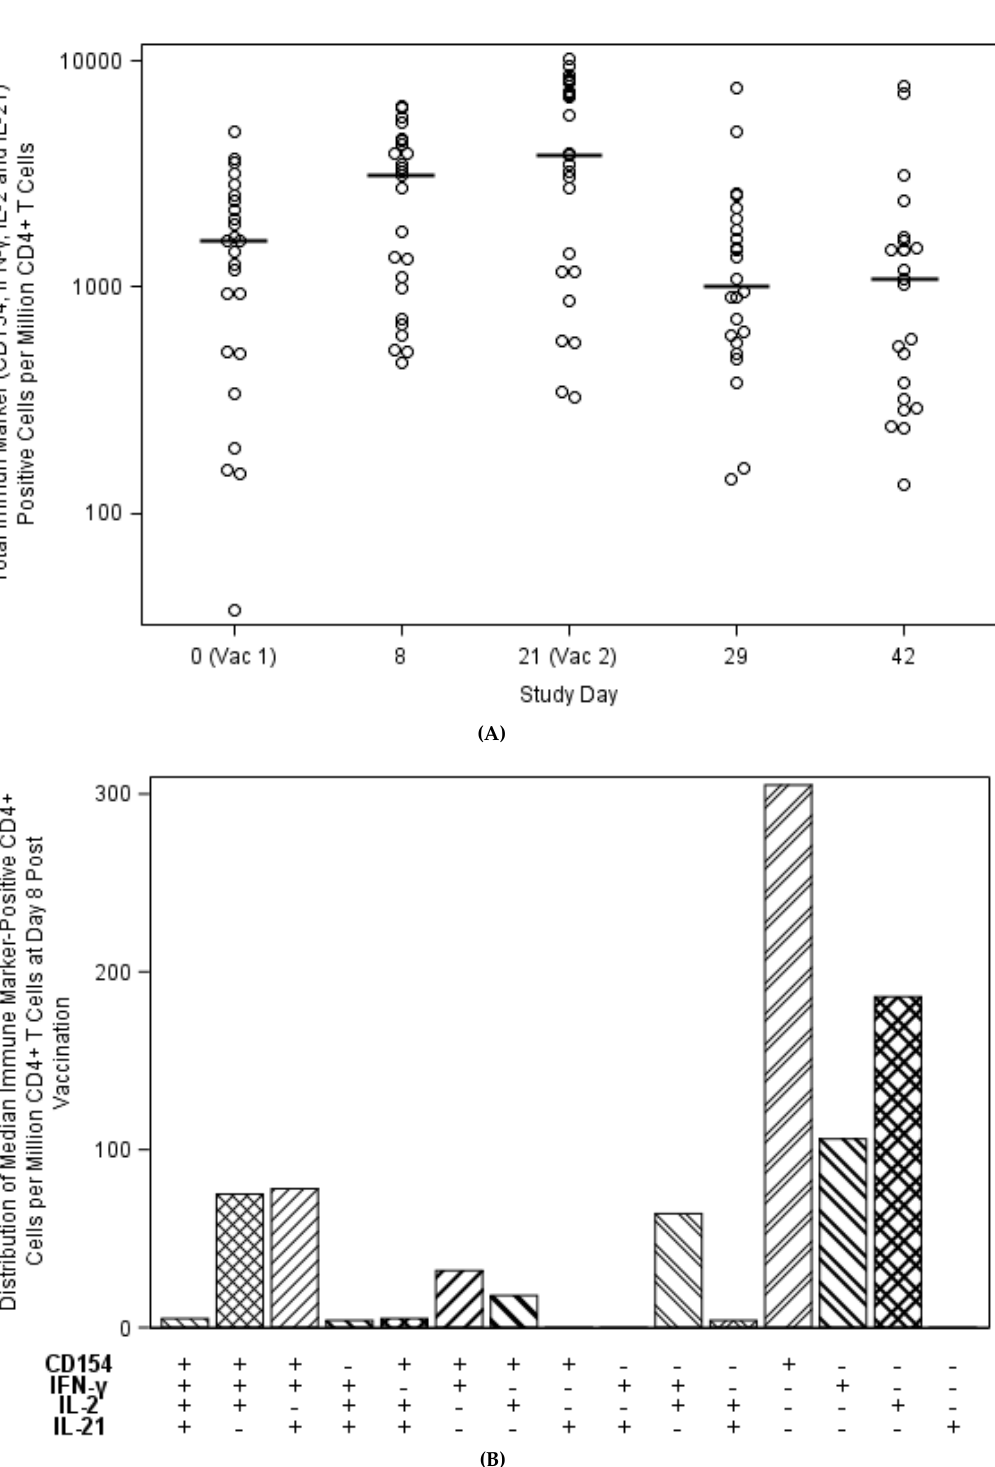
Table 5. Correlation of baseline CD4+T cell response with post vaccination antibody responses.